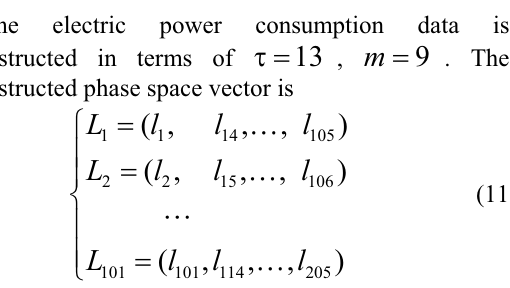
Fig.6. Relation between correlation dimension and embedded dimension